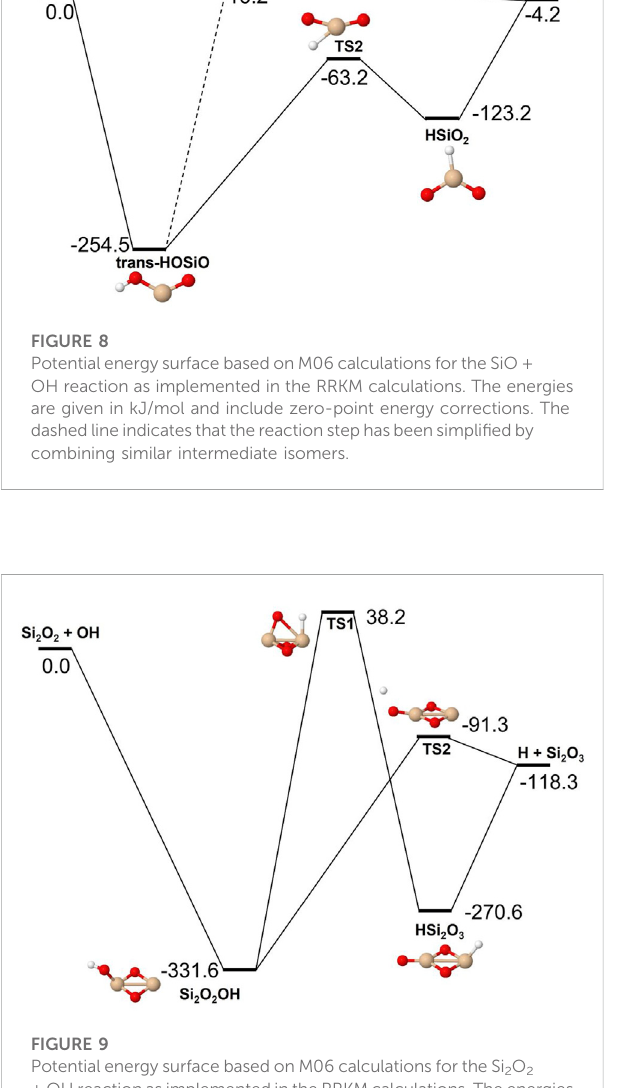
Potential energy surface based on M06 calculations for theSi 2 O 2 +OHreactionasimplementedintheRRKMcalculations.Theenergies are given in kJ/mol and include zero-point energy corrections.